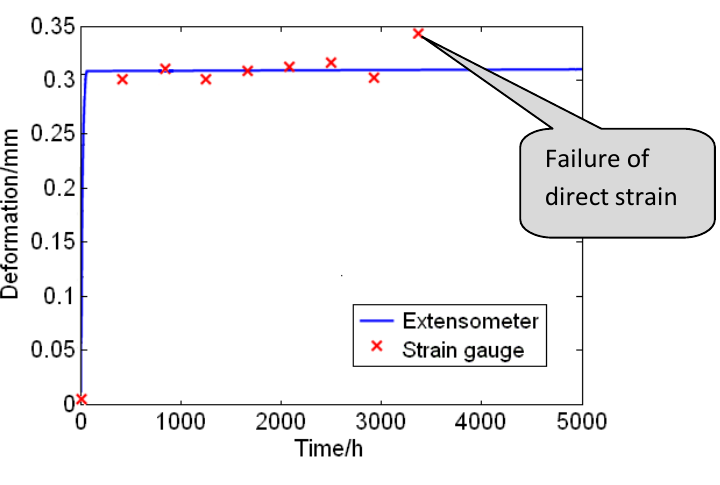
Figure 5. Deformation comparison of the extensometer and the strain